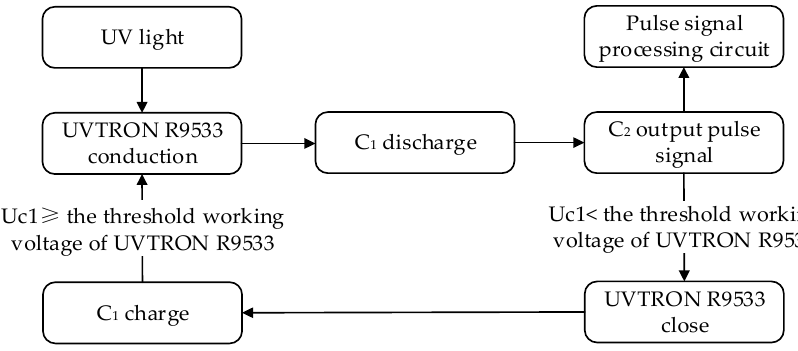
Figure 3. Drive circuit block diagram.